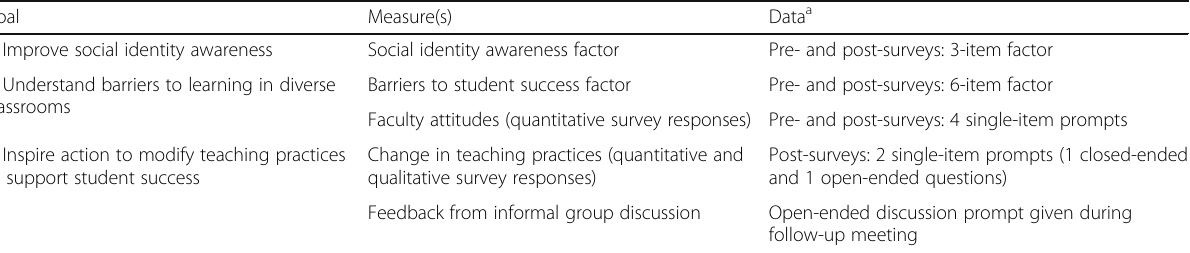
Table 3 Map of goals aligned with the corresponding measures and data collected during the study